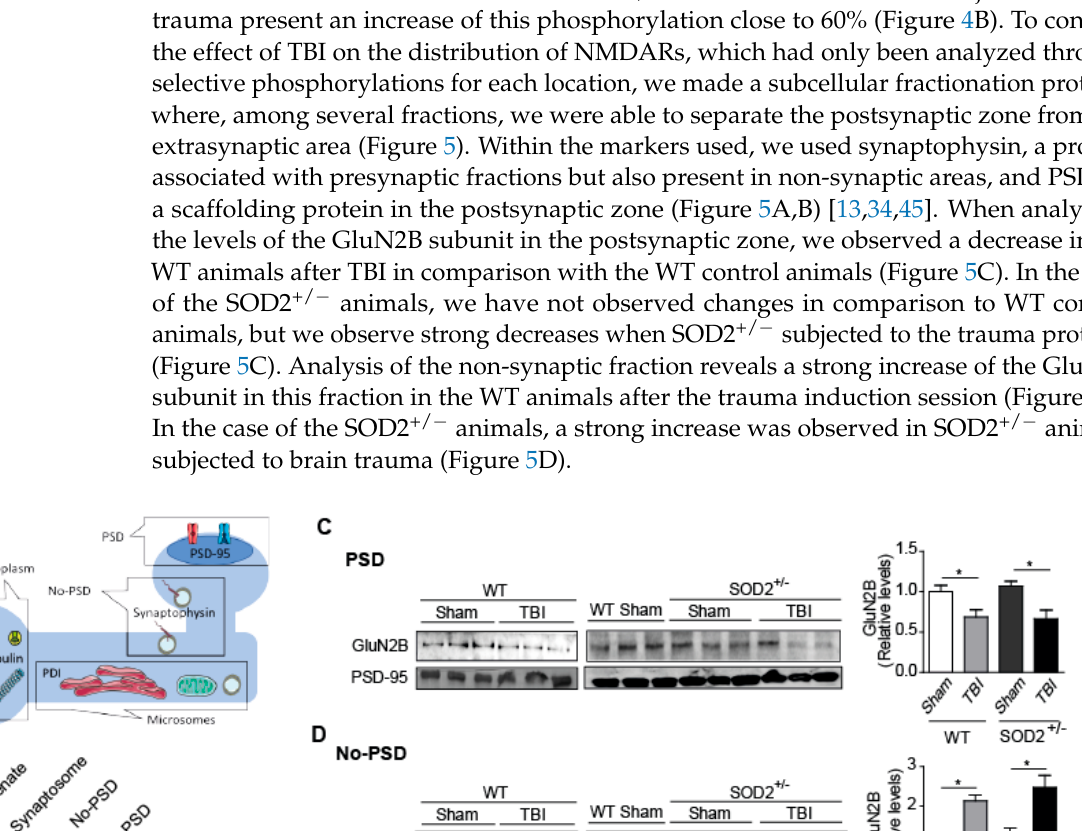
Figure 5. WT and SOD2 +/ − mice showed alteration in NMDARs subunit distribution after TBI. Scheme ( A ) and charac- terization ( B ) of proteins in the cytoplasm, synaptic, extrasynaptic, and intracellular membrane fractions. Representative western blot with equal amounts of total protein loaded (20 µ g) from each of the fraction probed with PSD marker PSD-95, the ER protein PDI, tubulin for cytoplasmatic fraction, and synaptophysin for the extrasynaptic fraction. Comparison of relative levels of NMDARs subunit Glun2B in synaptic ( C ) and extrasynaptic ( D ) fraction from hippocampi of WT and SOD2 +/ − under TBI condition. Six animals were used per experimental group. Statistically significant differences were calculated by one-way ANOVA, followed by Bonferroni’s post hoc test. The asterisk indicates the statistical significance of the observed differences. (* p <0.05). (PSD, postsynaptic